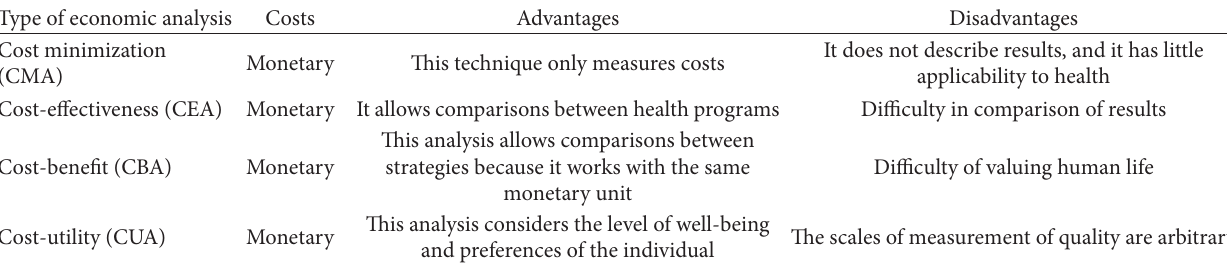
Table 1: Types of economic evaluation and their main characteristics.